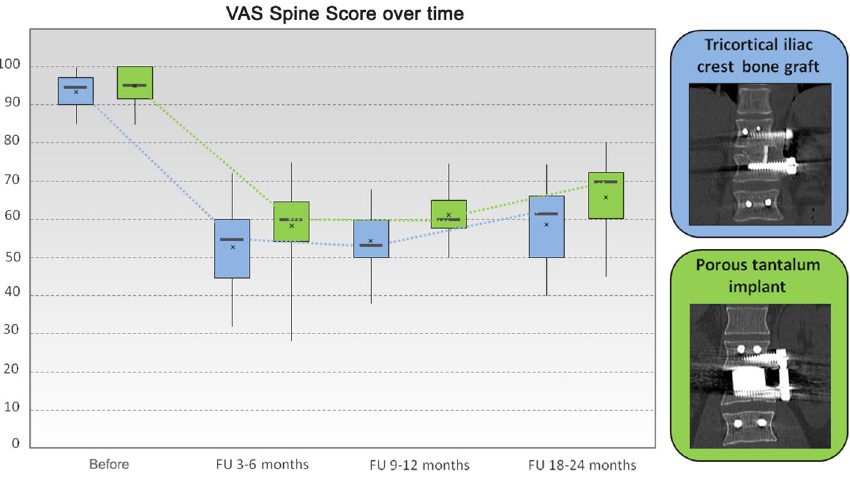
Figure 5. Box and whisker plot of the VAS spine score at all time points. For each box, the lower border is the 25th percentile, and the top border is the 75th percentile. The dark line in the middle of the box is the 50th percentile (the median), and whiskers denote the 2.5th and 97.5th percentiles. The cross indicates the mean